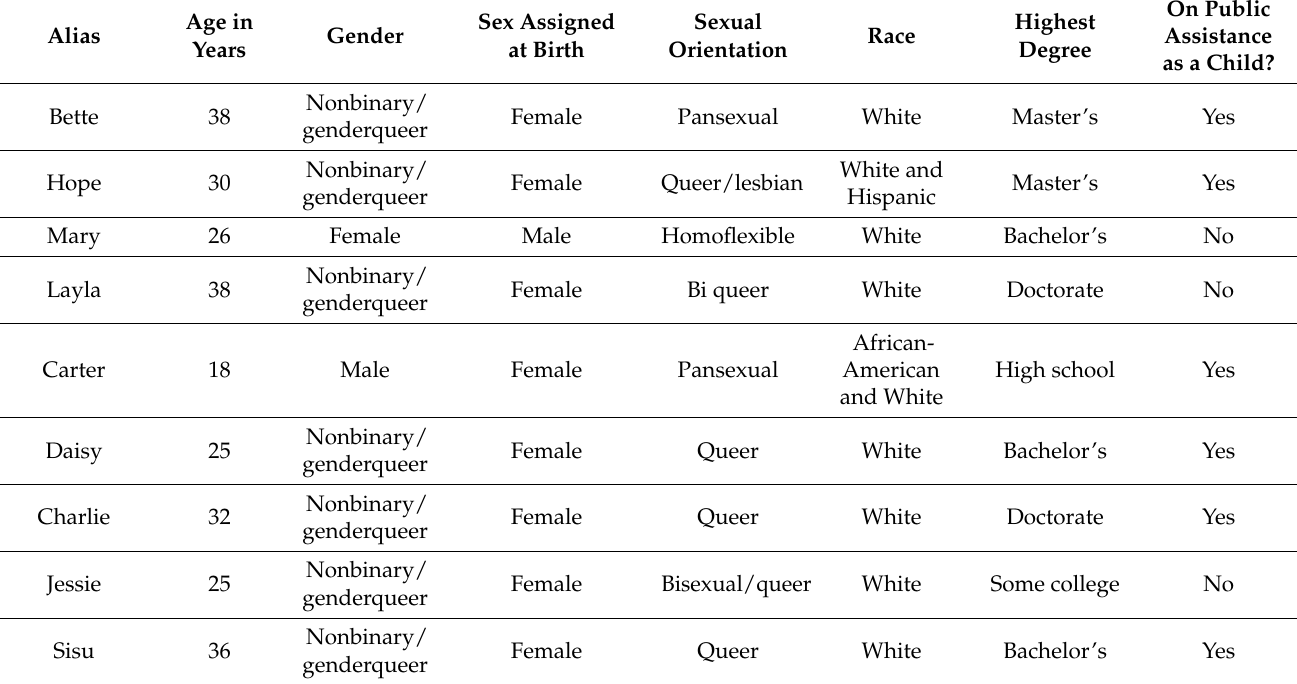
Table 1. Demographic Characteristics of